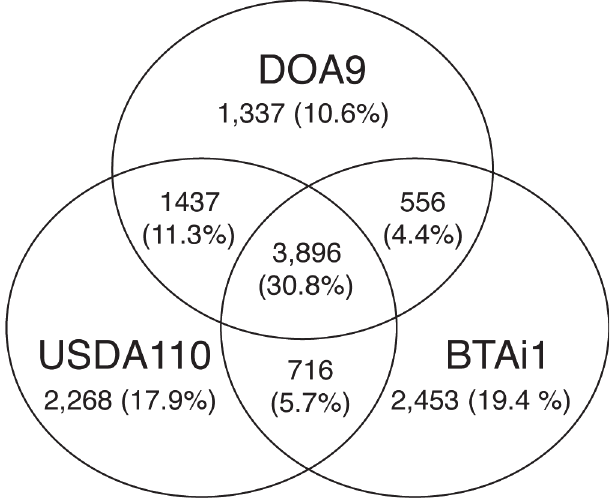
Fig 4. Comparative genomic analysis among Bradyrhizobium sp. DOA9, B . japonicum USDA110, and Bradyrhizobium sp. BTAi1. Each genome is represented by a circle, and the numbers of shared and unique genes are shown by the overlapping and nonoverlapping regions. The proportion of total genes represented by each area of the diagram is shown in parentheses. The total number of genes in each genome is shown in square